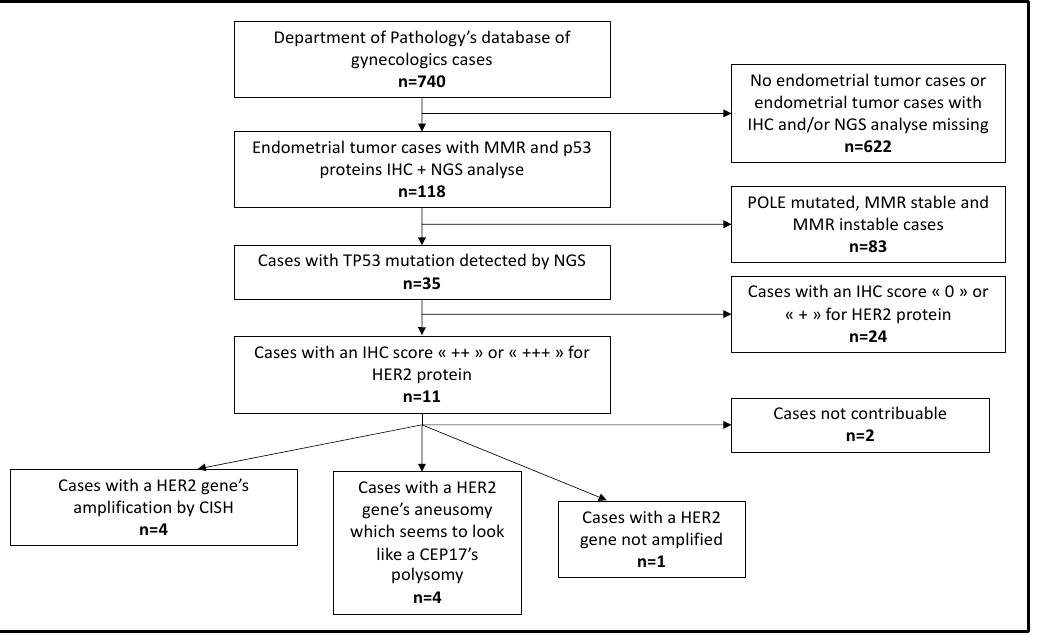
Figure 4. Flowchart of our study’s steps.